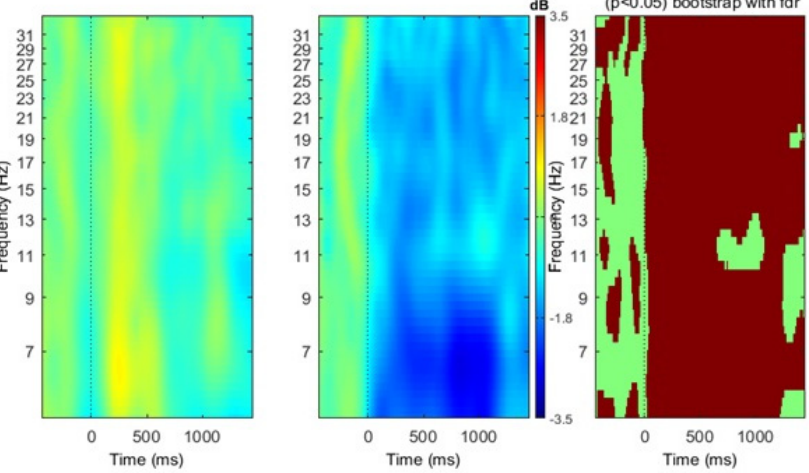
Figure 3. Left mu cluster event ‐ related spectral perturbations (ERSP) results. The first and second panels depict ERD, indicated by blue coloring, and ERS, indicated by red coloring, across time and frequency for picture and video verb naming conditions, respectively. The third panel depicts significant difference between the conditions, indicated by red coloring, ( p FDR < 0.05) with Bonferroni corrections for false discovery rates.